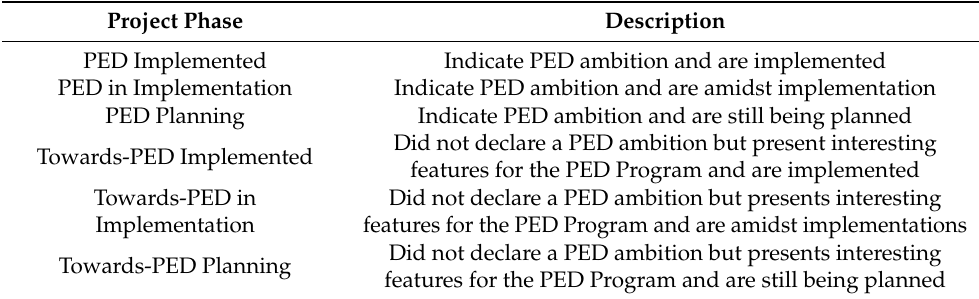
Table 2. Project groups according to PED ambitions and their development